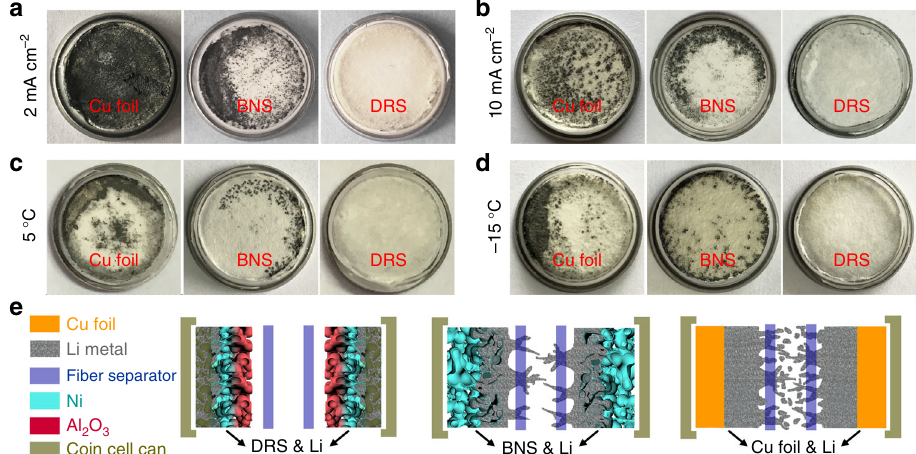
Fig. 6 Dendrite detection using symmetric cells including two separators. Optical images of the contact surfaces of two overlapping separators after cycling: a at 2 mAcm − 2 and room temperature (Cu foil for 150 cycles, BNS for 250 cycles, and DRS for 300 cycles), b at 10mAcm − 2 and room temperature (Cu foil for 50 cycles, BNS for 100 cycles, and DRS for 130 cycles), c at 5°C and 0.5mAcm − 2 for 100 cycles and d at − 15 °C and 0.5mAcm − 2 for 50 cycles. e Schematic diagrams of different Li-plating modes in cells using Cu foil, BNS, and